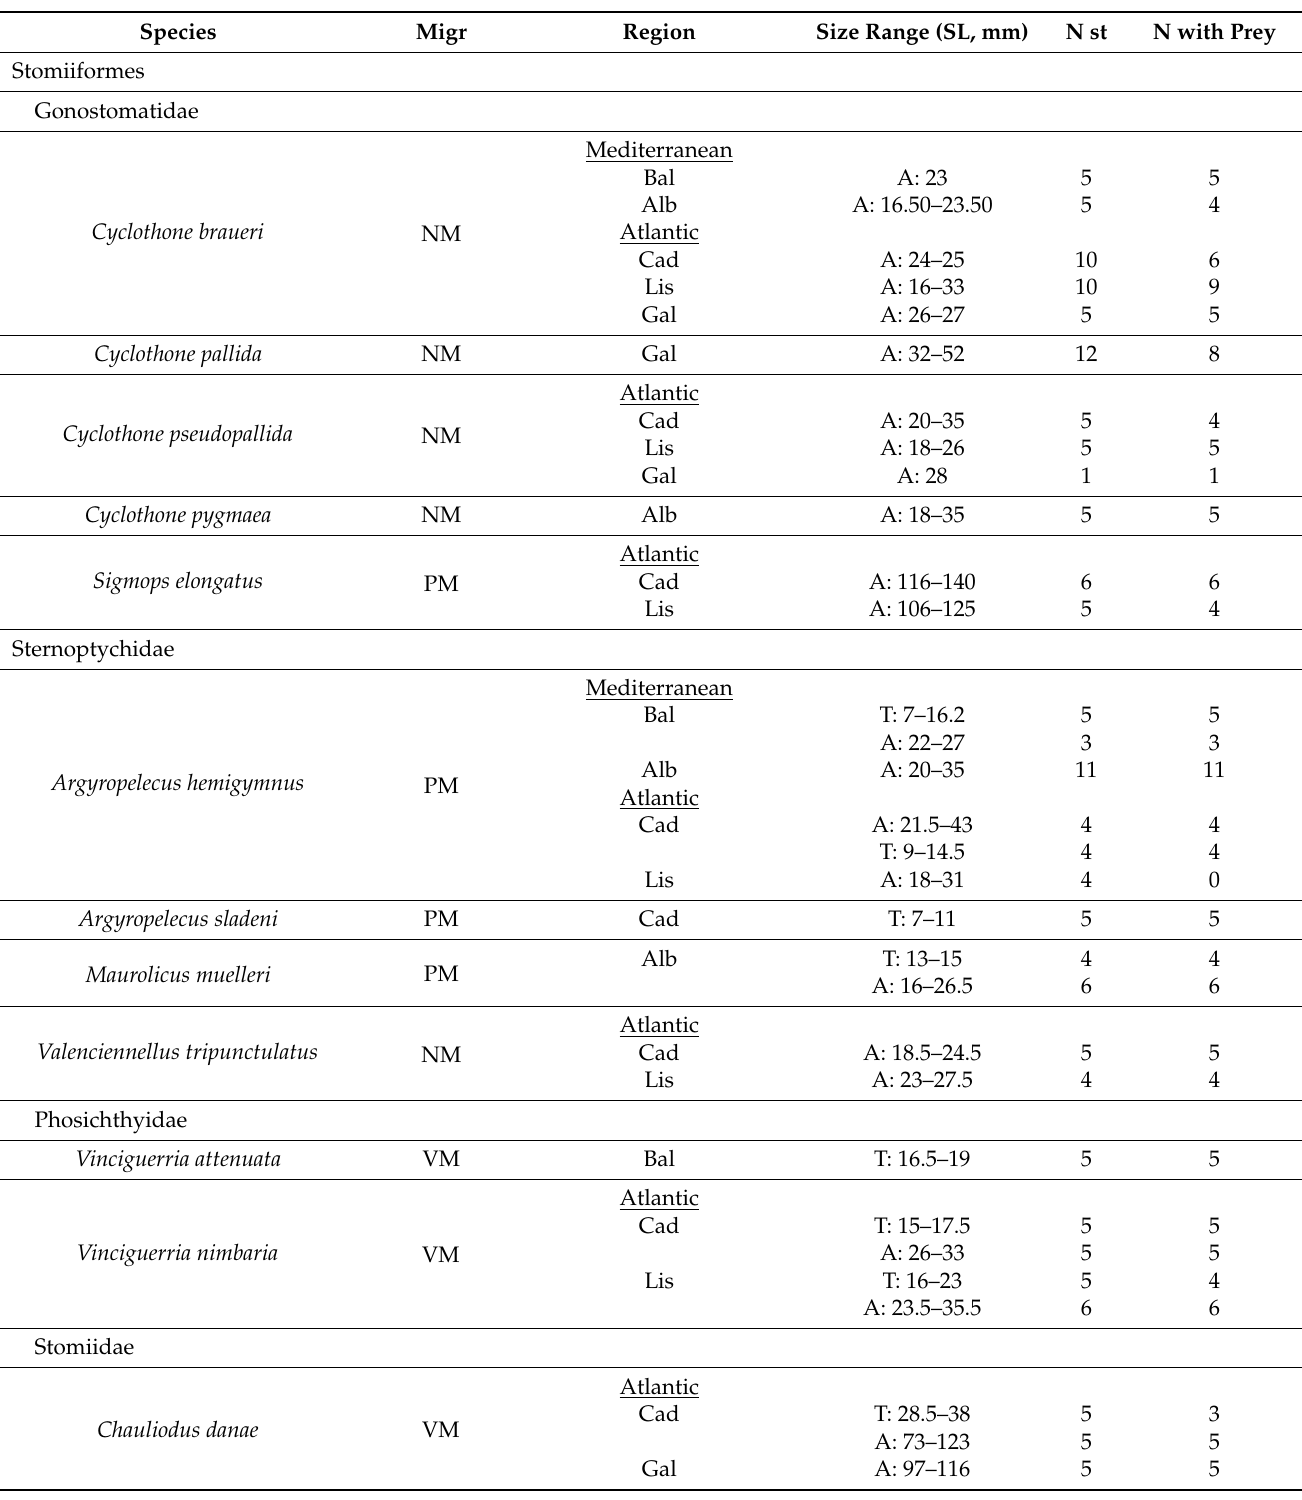
Table 1. Summary of fish samples examined for stomach content analyses from the Mediterranean and Atlantic regions selected for the study. Migr: migratory behavior (VM: vertical migrant; PM: partial migrant; and NM: non-migrant); SL: standard length (mm); T: transformation stage; A: adult stage; and N st: number of analyzed stomachs. Sampling zones: Bal: Balearic; Alb: Alboran; Cad: Gulf of Cadiz; Lis: Lisbon; and Gal: Galicia.